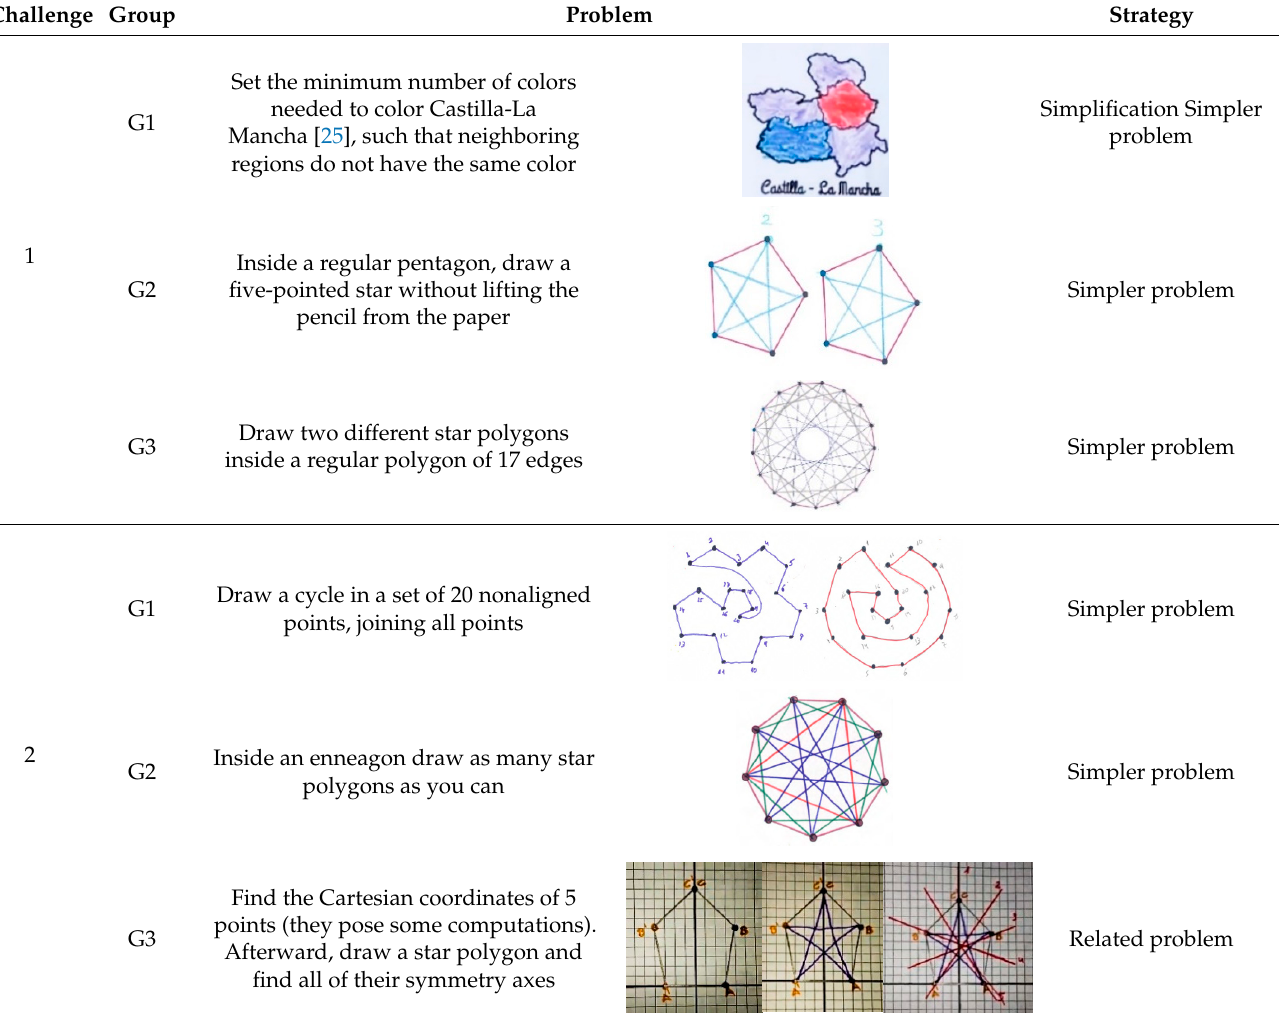
Table 4. Challenges posed by participants.